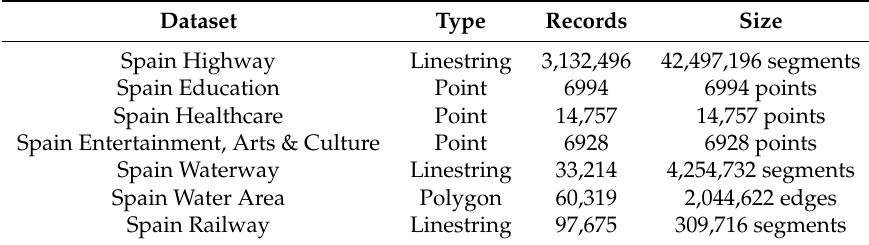
Table 8. Datasets used in the